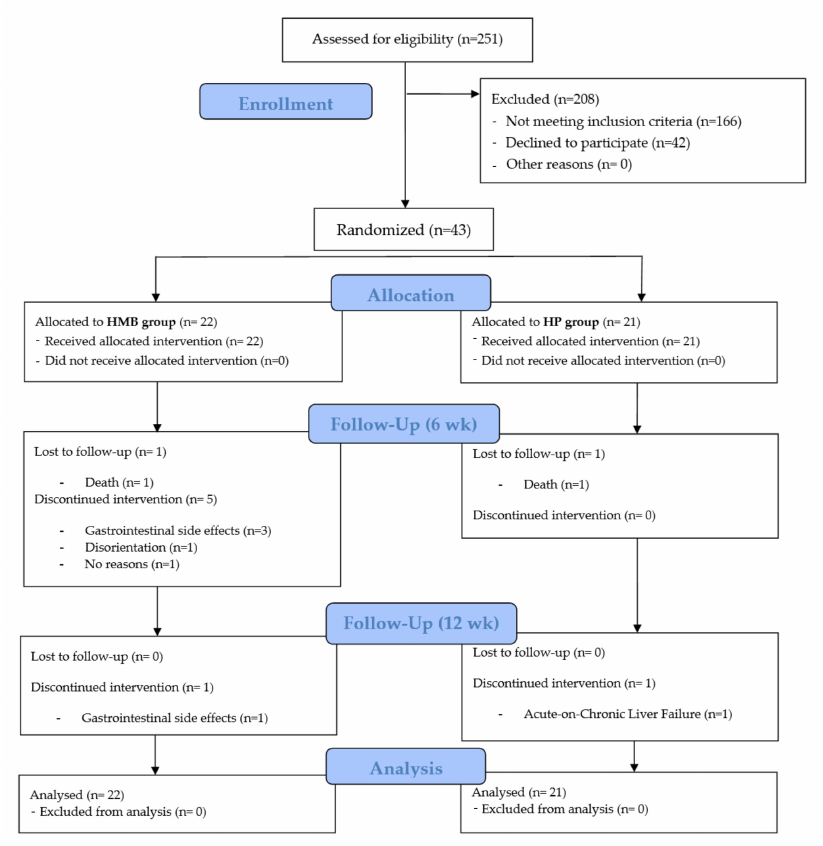
Figure 1. Study flow